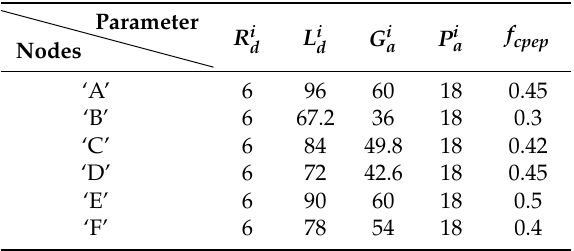
Table 4. Model inputs of this case